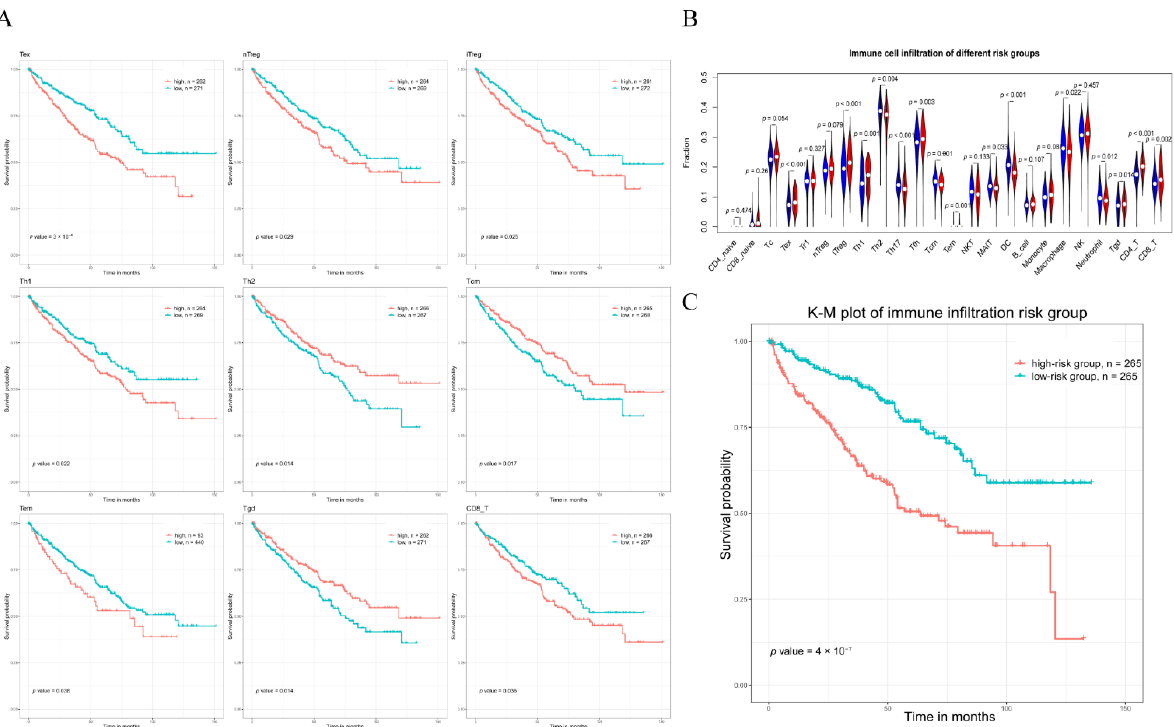
Figure 4. Analysis related to immune infiltration. ( A ) KM curves of immune cells (high-immune cell abundance vs. low-immune cell abundance) that significantly associated with OS. ( B ) Violin plot of 24 immune cells abundance between high-Riskscore gene group (red) and low-Riskscore gene one (blue), and p < 0.05 showed a significant difference between the two groups in immune cell expression. ( C ) KM plot (high-Riskscore immune vs. low-Riskscore immune groups) for KIRC patients.